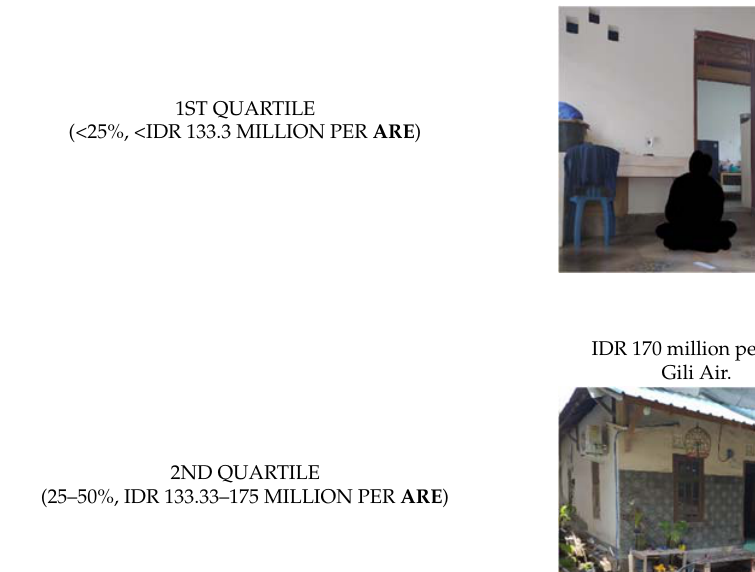
Figure 5. Interpolation of residential property prices for Gili Matra Islands (Model HR1). Table 2. Distribution of case examples in each quartile of residential property prices. Quartile Case Example Location IDR 75 million per are .